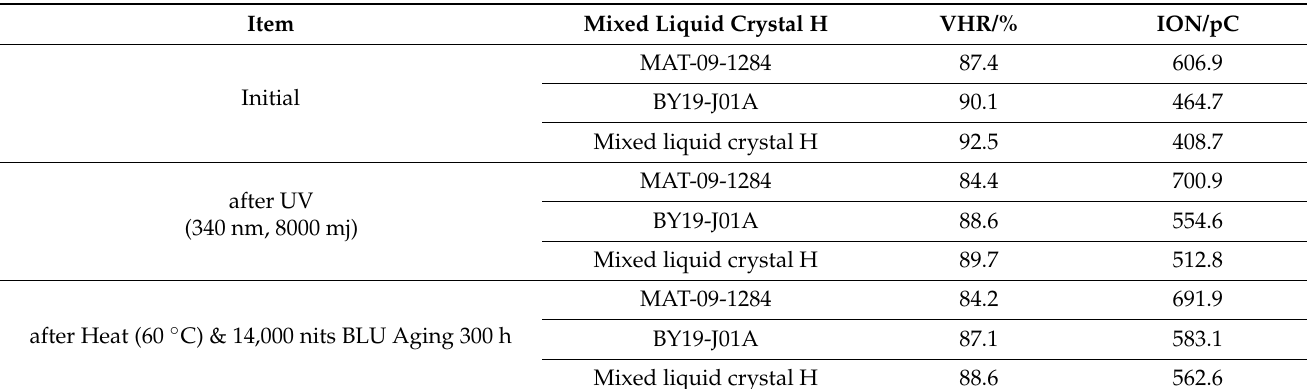
Table 5. The photo-stability of mixed liquid crystal H.